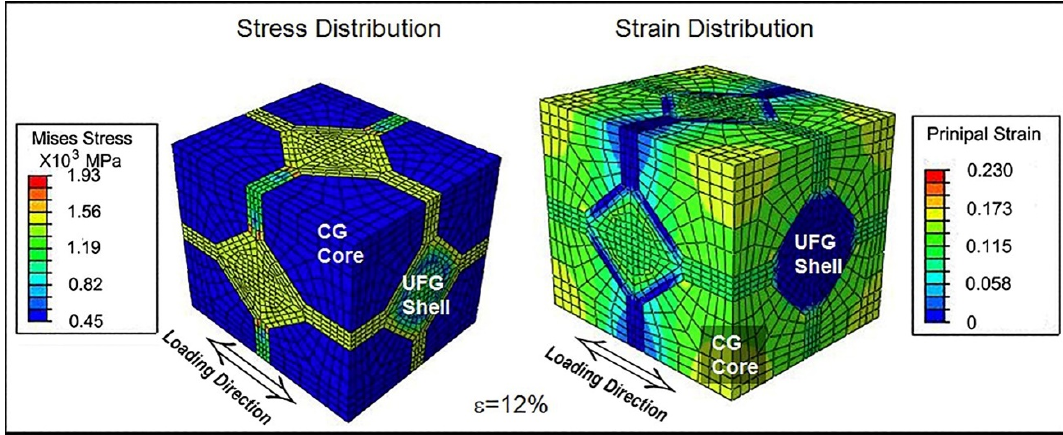
Figure 10. ECCI of pure Ni HS after 5% tensile deformation. ( a ): shell and ( b ): core.